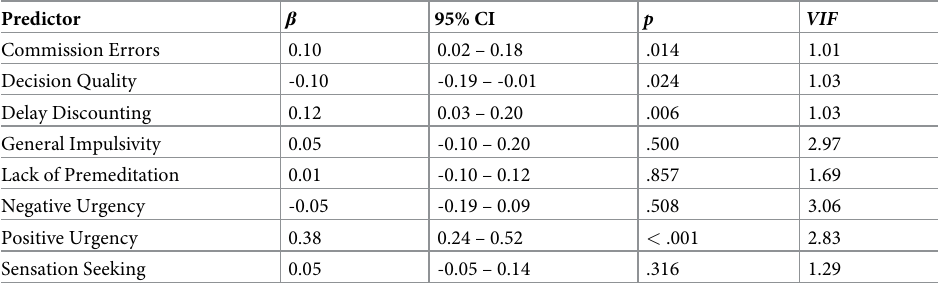
Table 3. Regression Model 2 results predicting the affective facet.